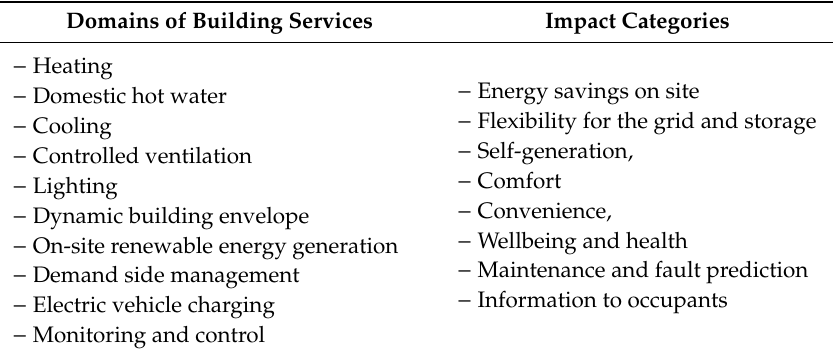
Table 3. Smart readiness indicator (SRI) domains and impact categories